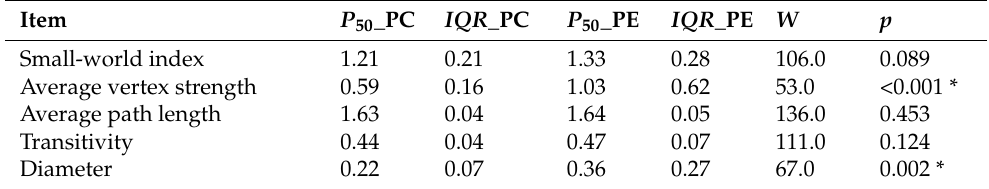
Table 2. Univariate analysis of static network characteristics.